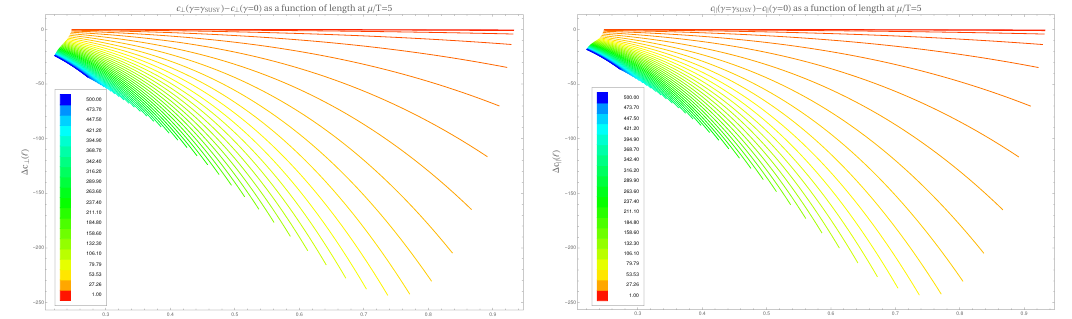
Figure 17 . We display the difference between the c-functions, ∆ c as computed with and without Chern-Simons coupling. Left: ∆ c ⊥ Right: ∆ c . In both images these are displayed as a function of || dimensionless length lB 1 / 2 at fixed µ/T = 5 for B/T 2 varying from B/T 2 = 1 . 00 to B/T 2 = 500 . 00 .